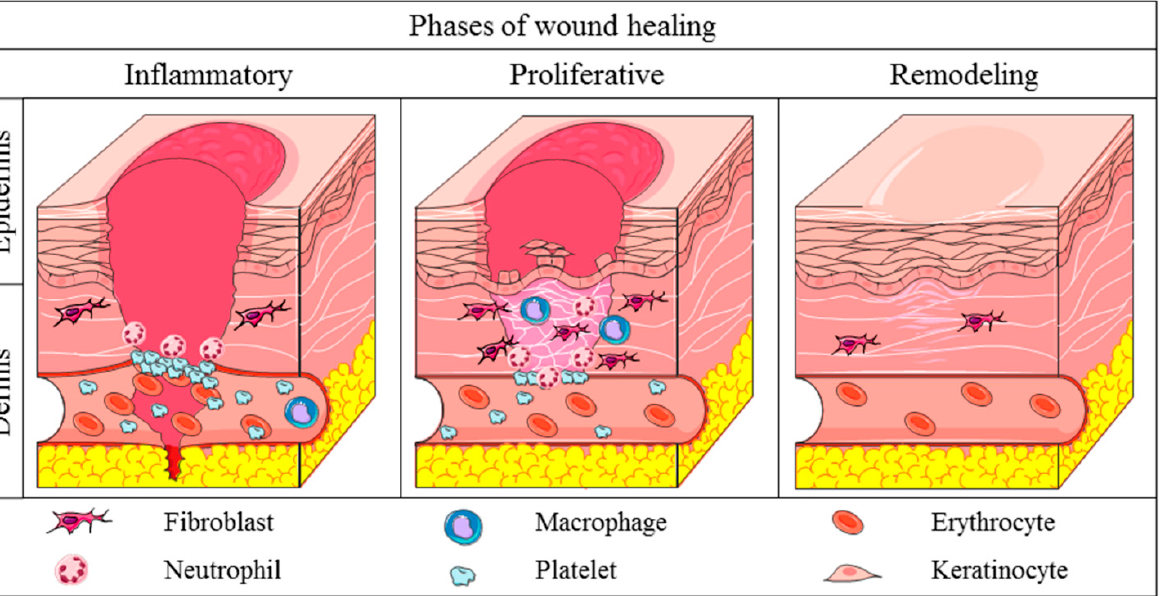
Figure 1. Different phases in skin wound healing (Reproduced with permission from [5]).